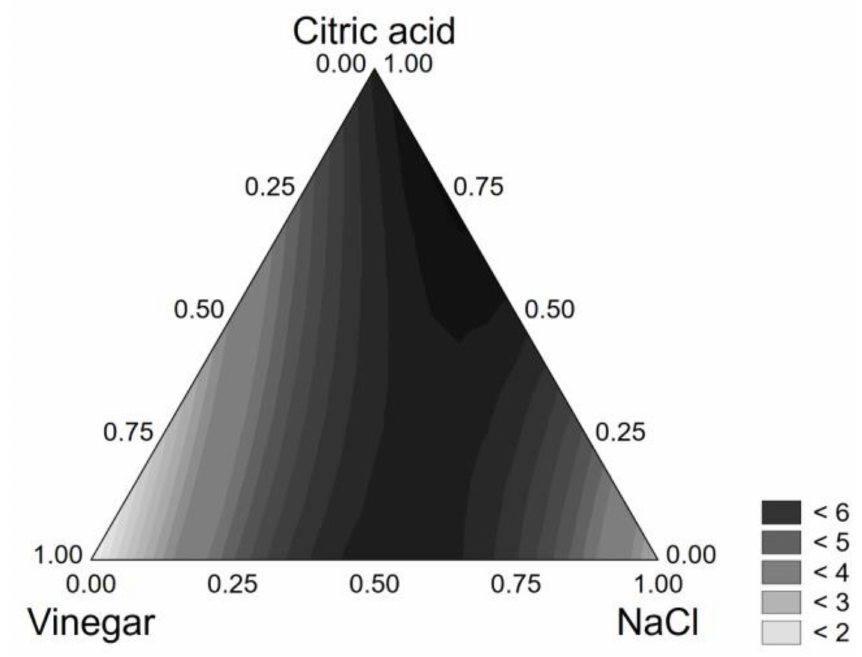
Figure 2. Ternary plot for the viability loss of L. plantarum 68 after 24 h in the model